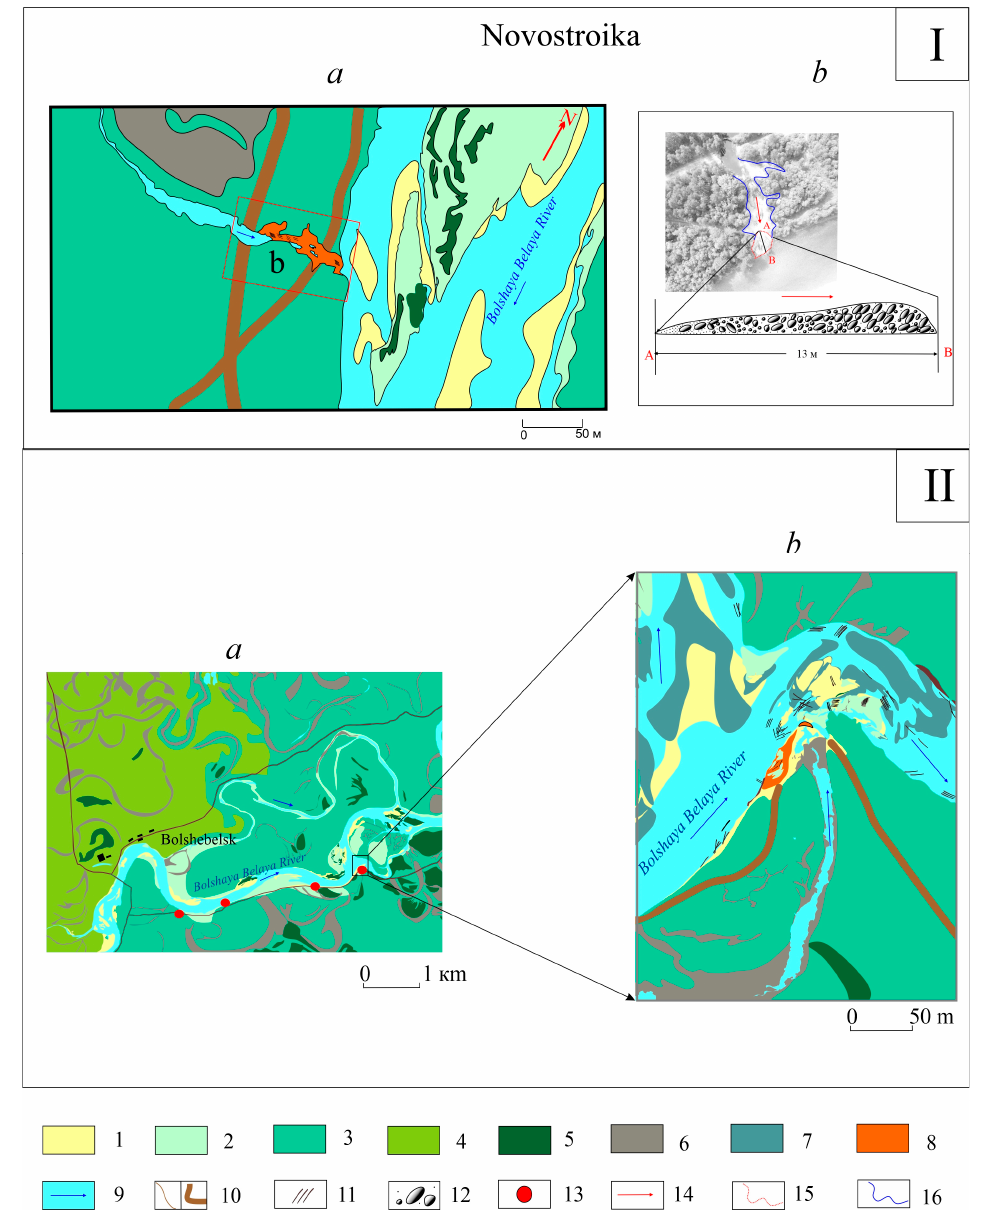
Figure 10. Floodplain–channel complexes of the Bolshaya Belaya River in the area of observation